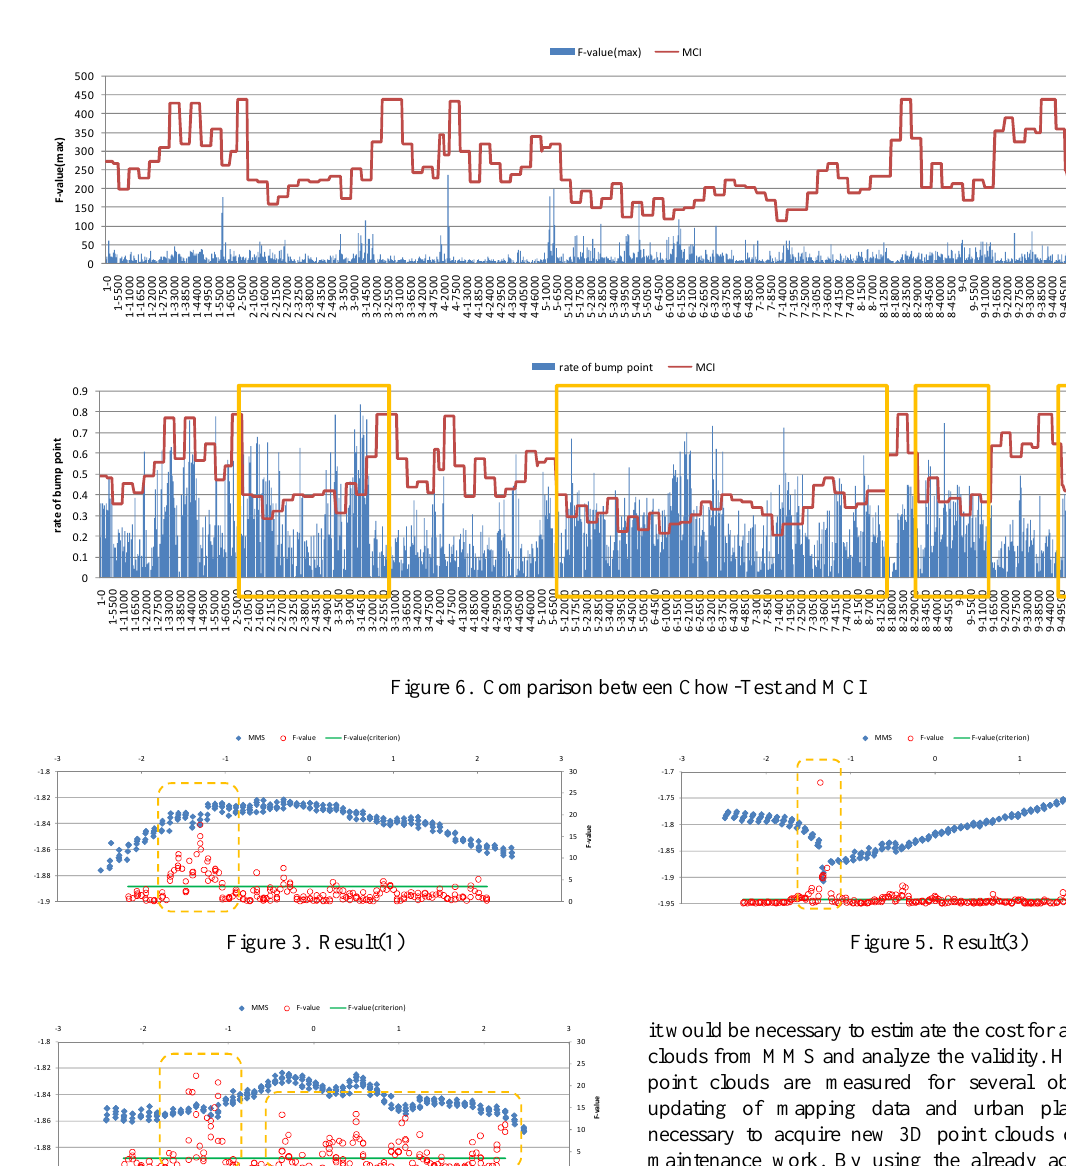
Figure 4. Result(2)